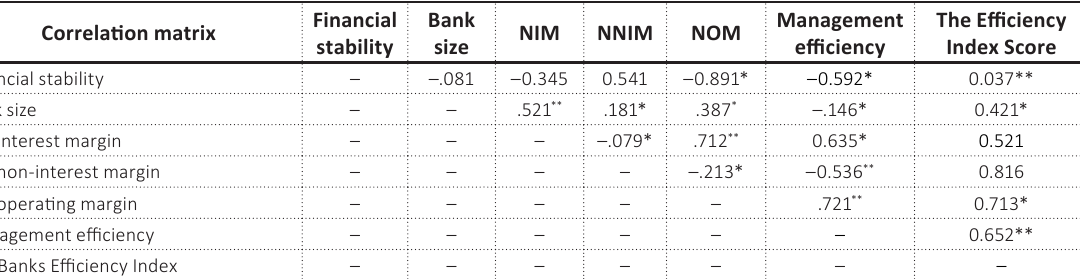
Table 10. Correlations matrix for Model C